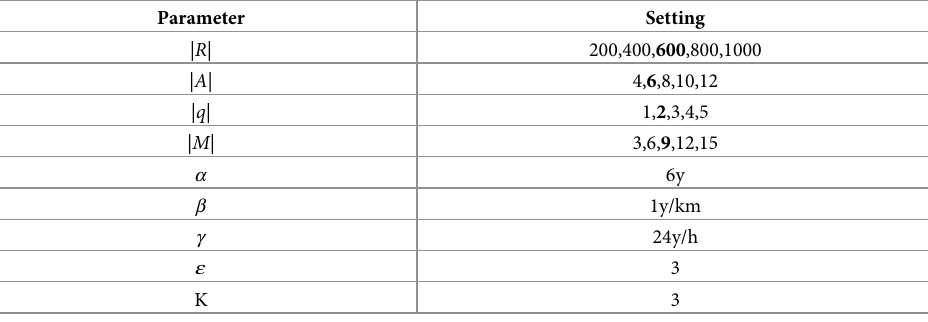
Table 5. The parameter settings for real